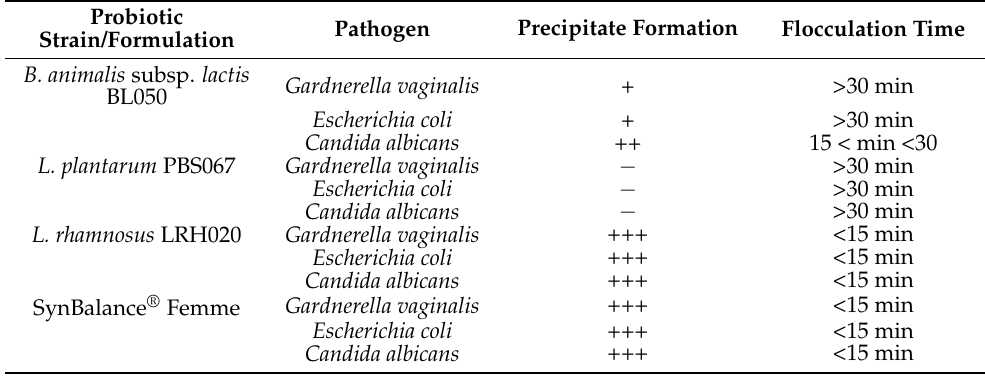
Table 6. The visual check of precipitate was expressed as cluster quantity ( − , +, ++, +++) and the flocculation time was recorded in minutes (min).